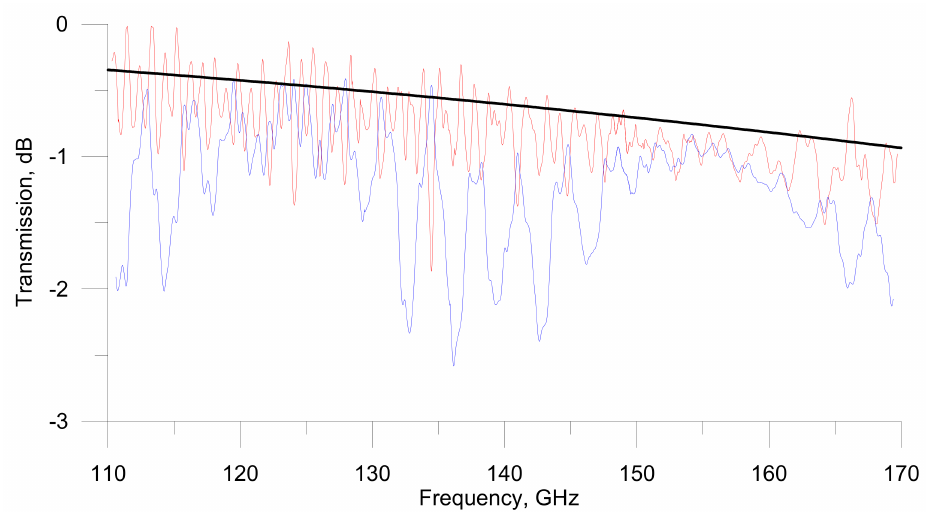
Figure 7. Reflection from the 3D-printed disk with special one-dimensional corrugation on both sides. The black line corresponds to the numerical simulation in CST Studio. The blue line is the measured reflection coefficient, and the red line is the lower sensitivity limit of the measurement setup.